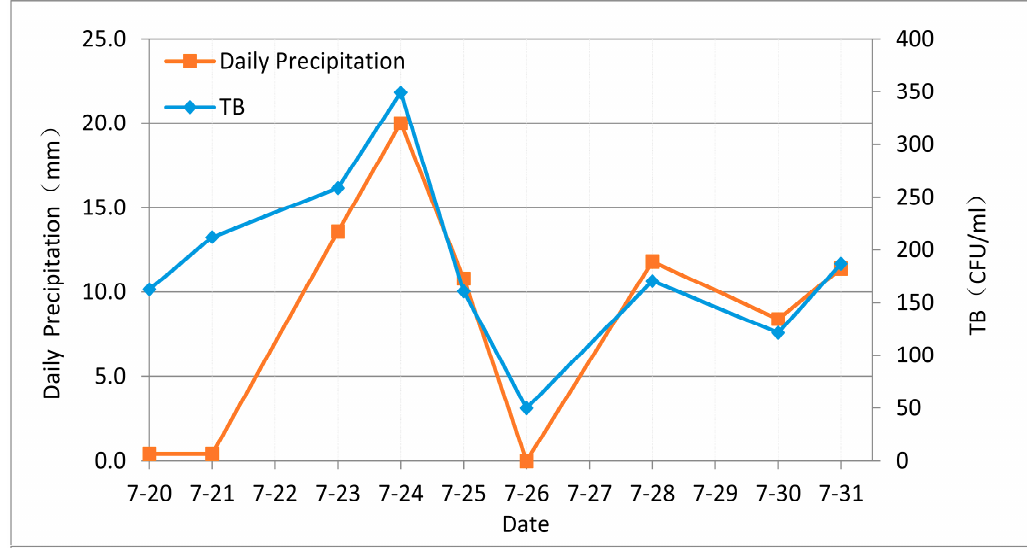
Figure 6. Changes in daily precipitation and TC from 20 July 2014 to 31 July 2014.